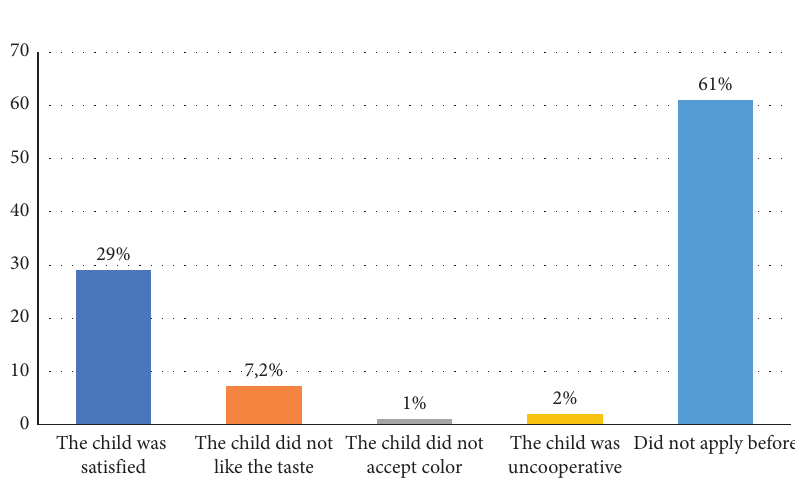
Figure 1: Parents’ perceptions about fuoride varnish previous